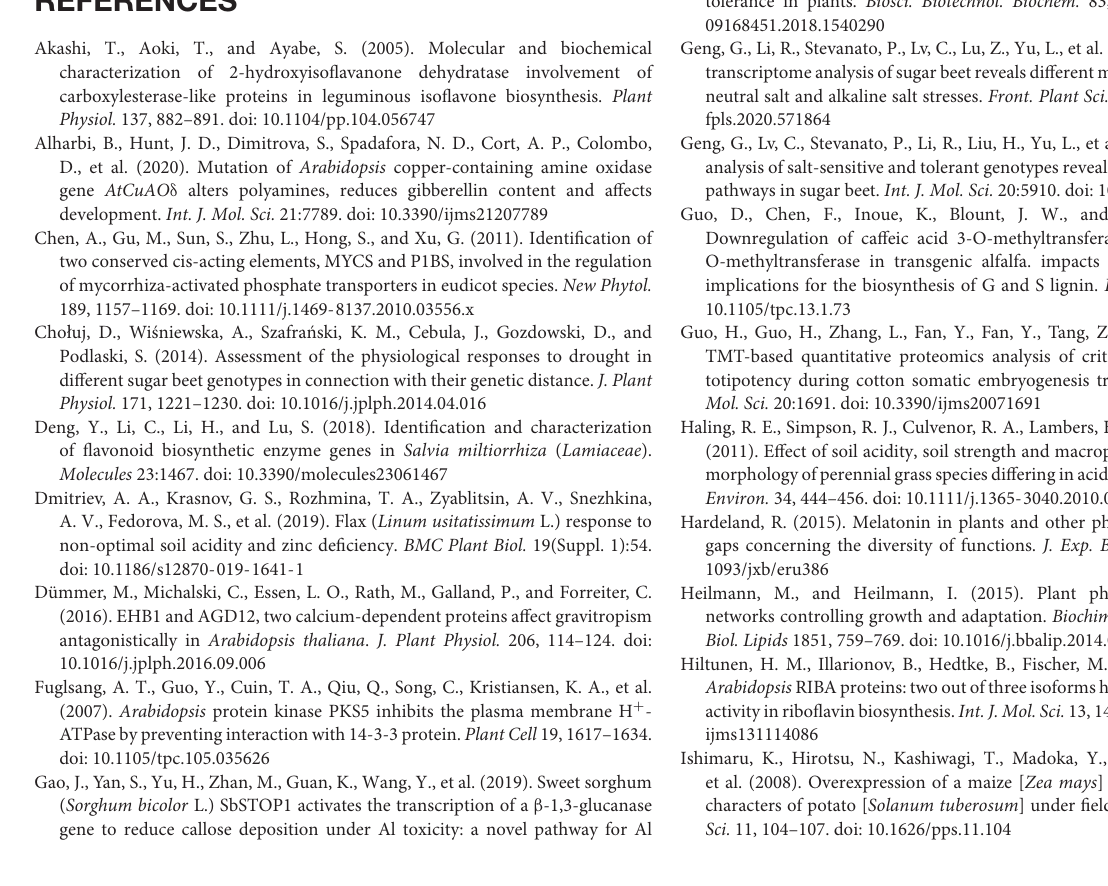
Supplementary Figure 3 | The GO (Gene Ontology) enrichment analysis of identified differentially expressed proteins (DEPs) in the leaves and roots of sugar beet in different pH comparison groups.